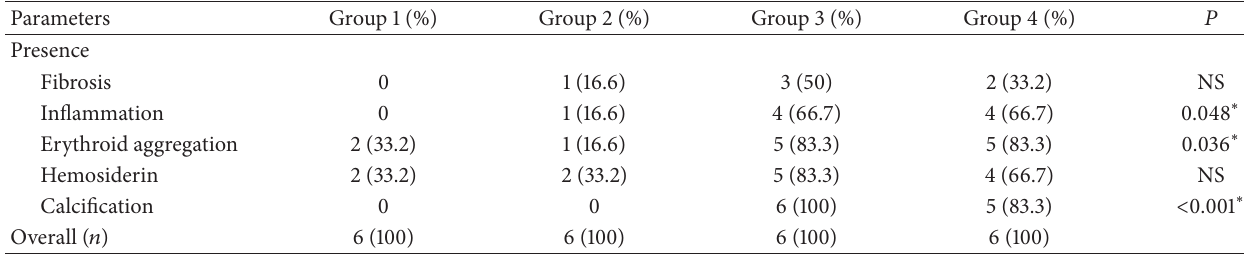
Figure 8: Bleeding and congestion without erythrocyte aggregation with significant calcification in Nanopeptide group (10xHE). Table 2: Histopathological features of study